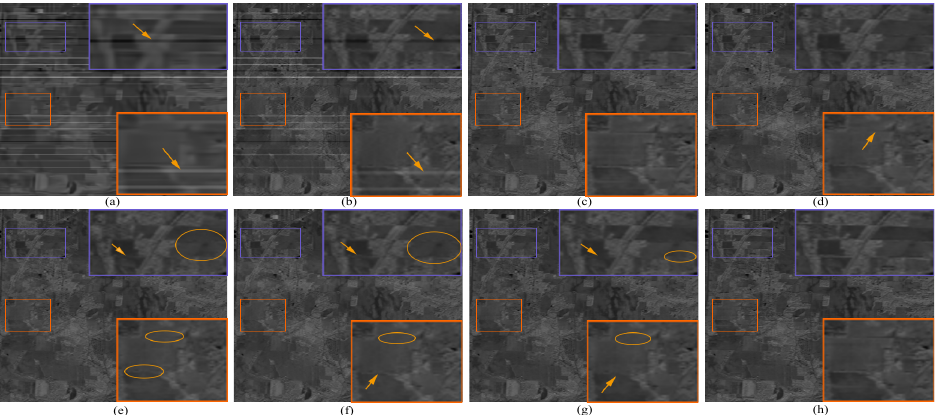
Figure 9. Results of different methods for simulated stripe AVIRIS hyperspectral data S3. ( a ) BM3D; ( b ) SNRCNN; ( c ) GF-based; ( d ) WAFT; ( e ) UV; ( f ) HUTV; ( g ) SUV; ( h )